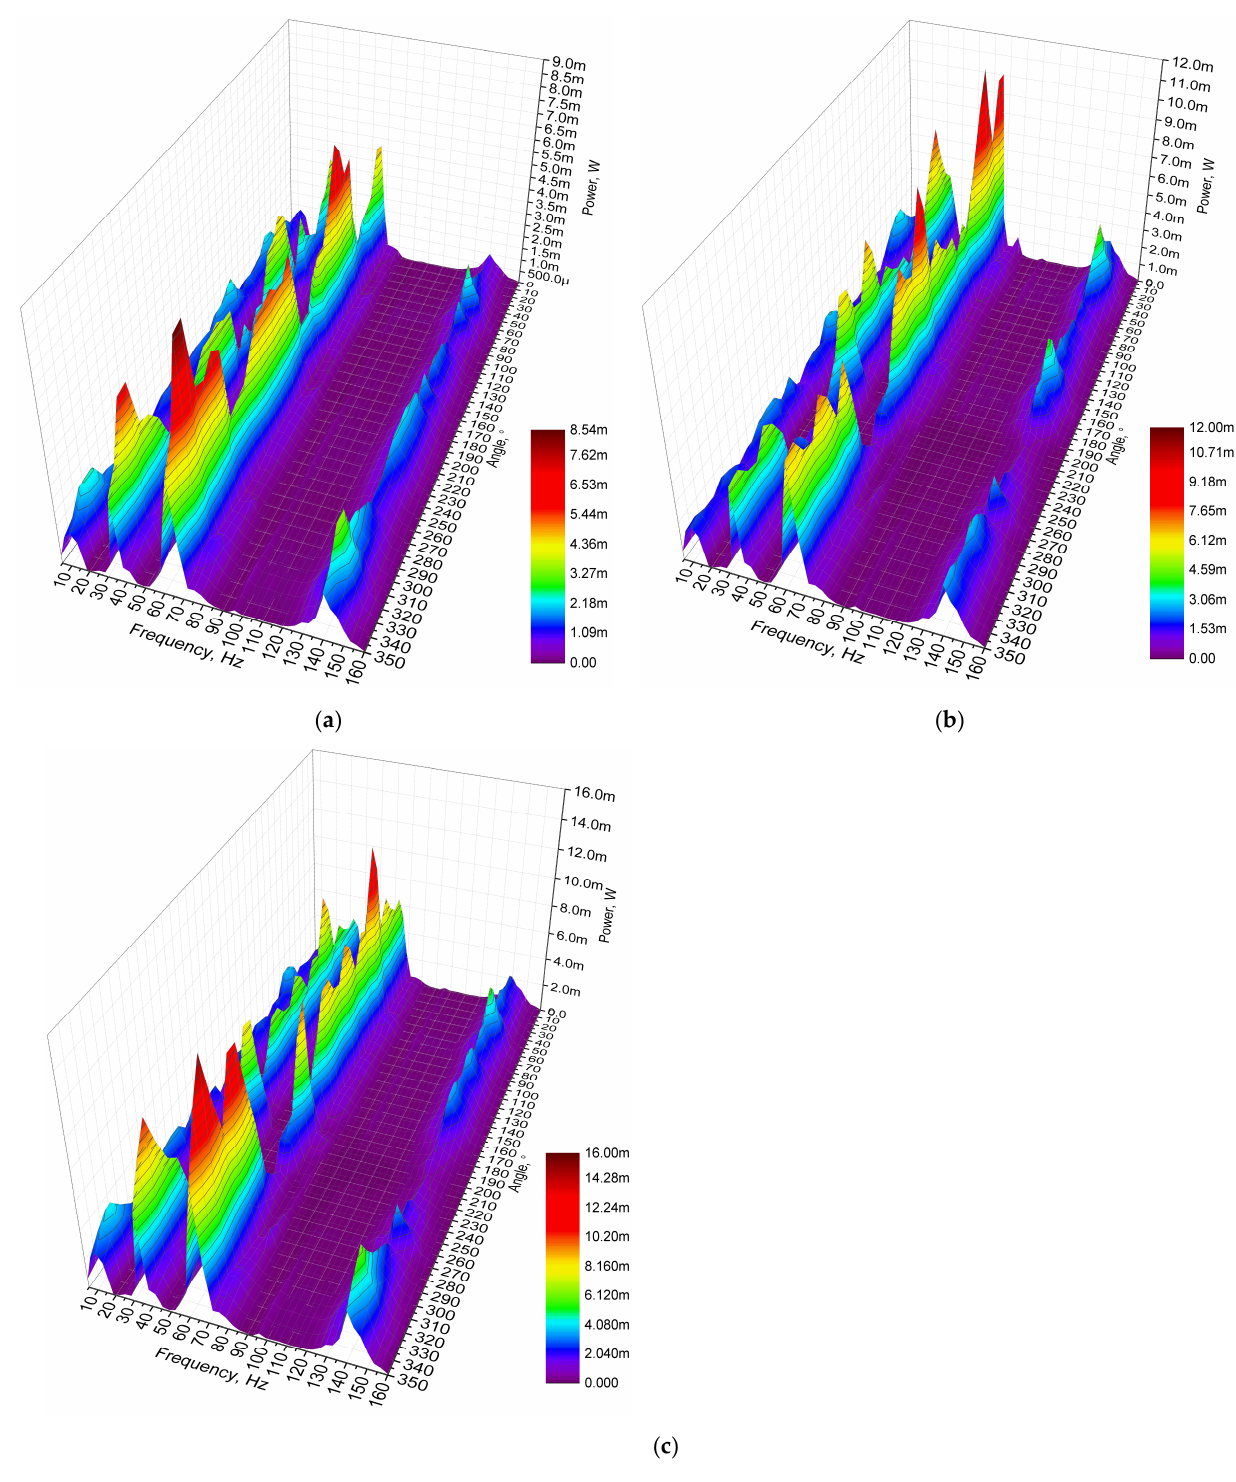
Figure 22. Frequency—power—angle of excitation motion characteristics of the energy harvester with different loads; ( a )—load equal to 1 MΩ; ( b )—load equal to 500 kΩ; ( c )—load equal to 250 kΩ.